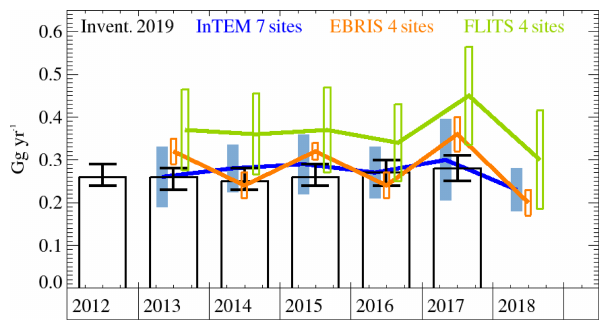
Figure 5. Map of the top-down emission estimate from China and East Asia. The red line indicates the boundary of the region we denote “eastern mainland China”, to which the measurements at Gosan and the inversion method are most sensitive.